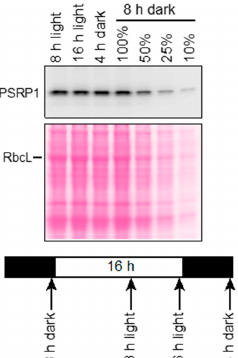
Figure 1. Plastid Specific Ribosomal Protein 1 (PSRP1) abundance during a diurnal cycle in maize. Seedlings (inbred line B73) were grown in diurnal cycles, and leaves were harvested at the indicated times on the eighth day after planting. Total leaf extracts were fractionated by SDS-PAGE, and PSRP1 was detected by immunoblotting. An image of the Ponceau S-stained filter is shown to illustrate equal sample loading and the abundance of the large subunit of Rubisco (RbcL).